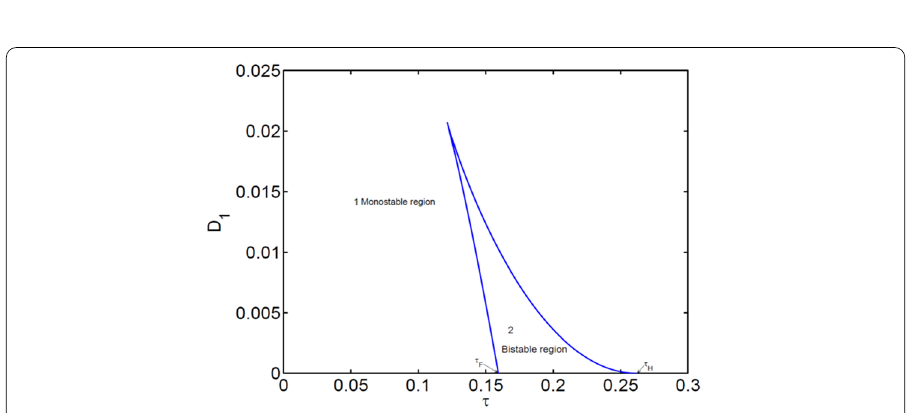
Figure 8 Transition set curves under additive noise excitation (taking τ and D 1 as unfolding parameters)